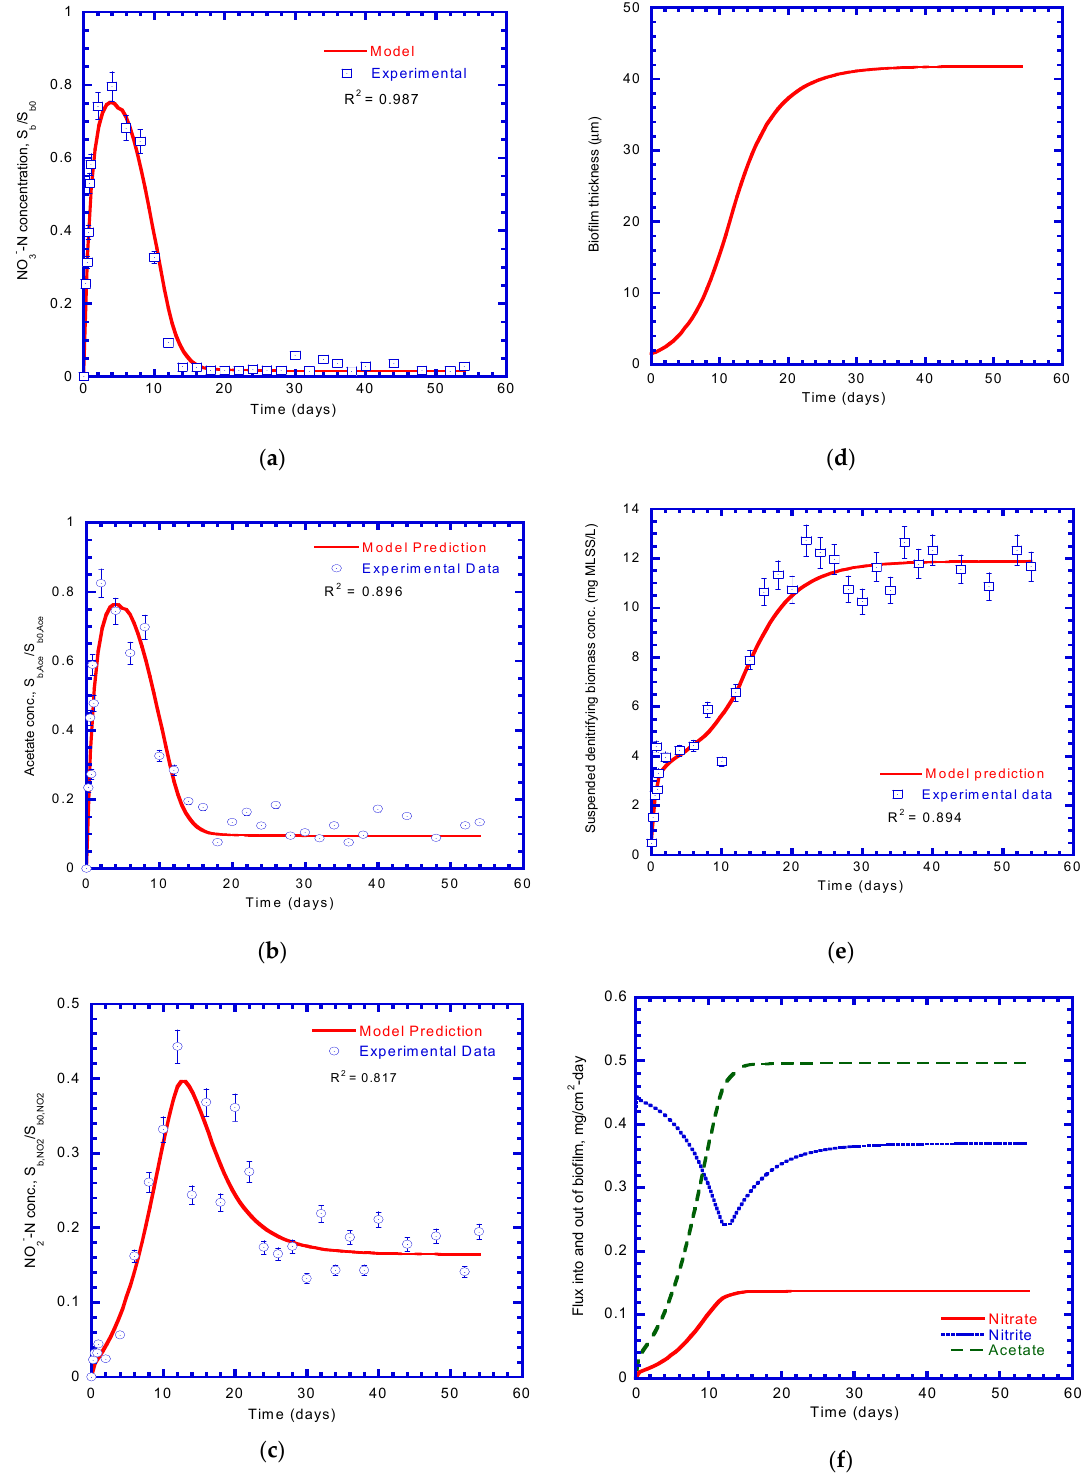
Figure 8. Experimental data and model predictions in the biofilm system: ( a ) nitrate effluent, ( b ) acetate effluent, ( c ) nitrite effluent, ( d ) biofilm growth, ( e ) suspended biomass growth, and ( f ) flux into and out of the biofilm.